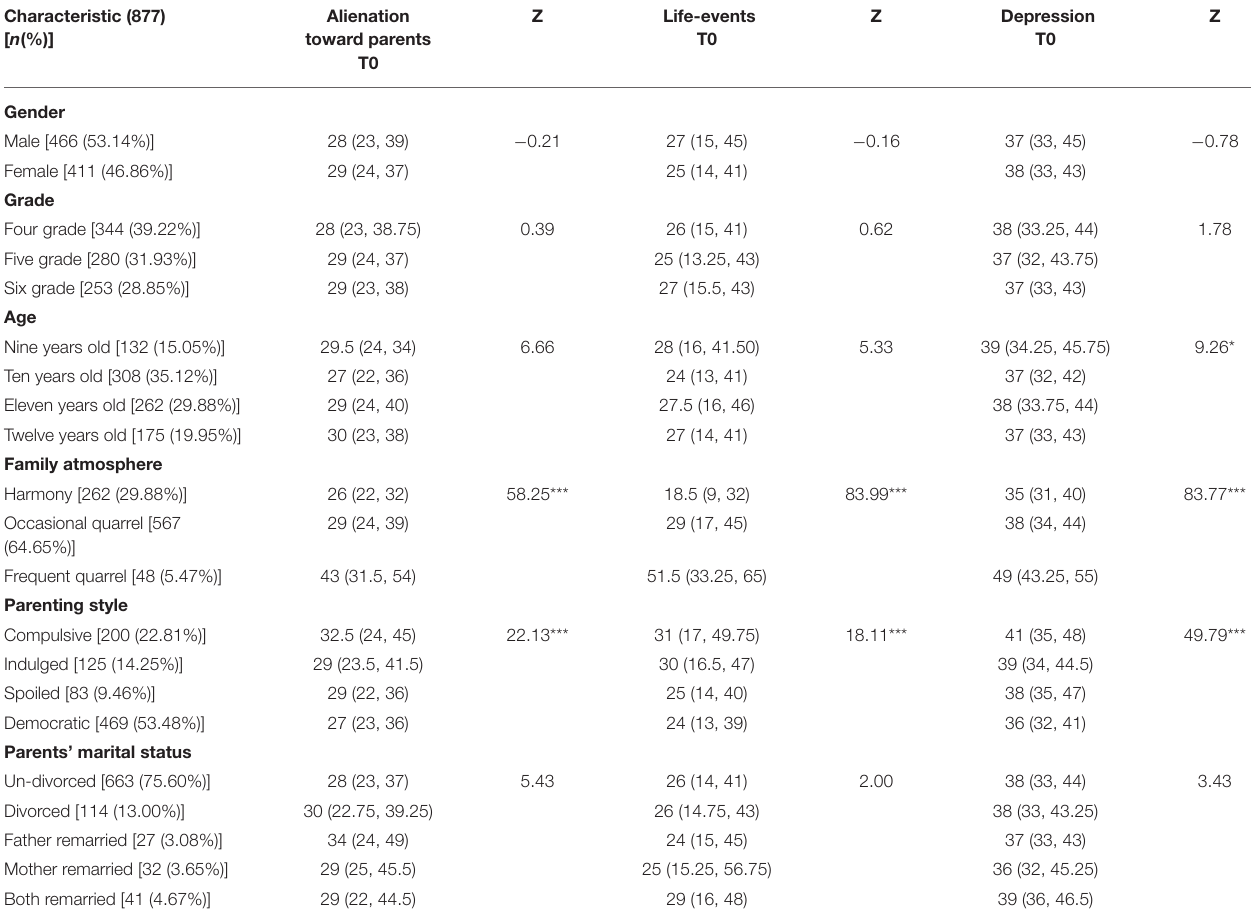
TABLE 1 | Demographic characteristics of alienation toward parents, life-events, and depression at baseline [M(P 25 , P 45 )]. Characteristic (877) [ n